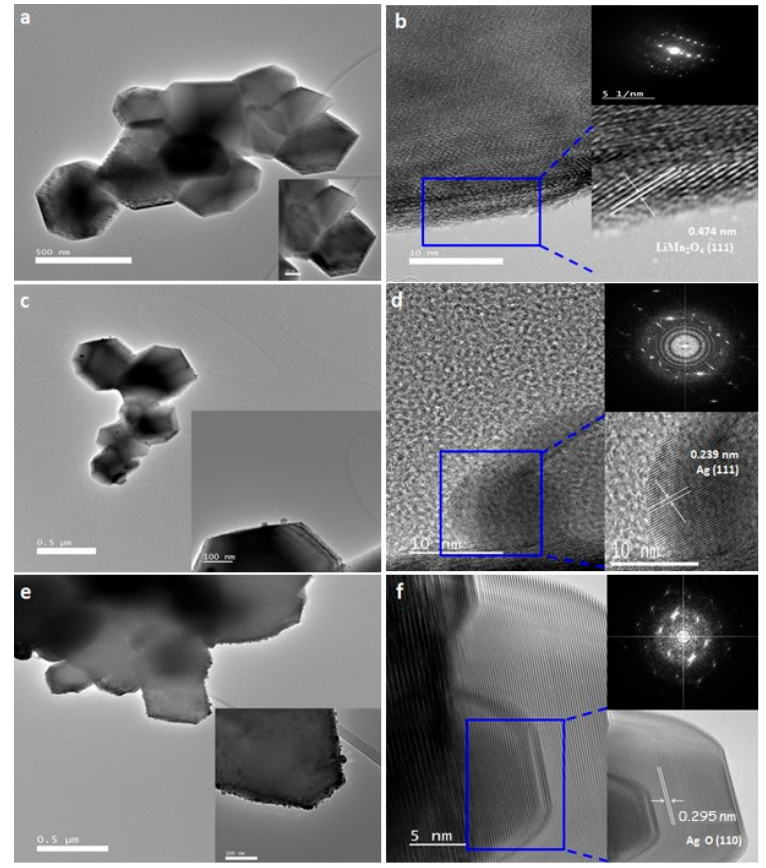
Figure 9. TEM images at different magnifications of: ( a , b ) pristine LMO; ( c , d ) Ag/LMO(v); and ( e , f ) Ag/LMO(a).